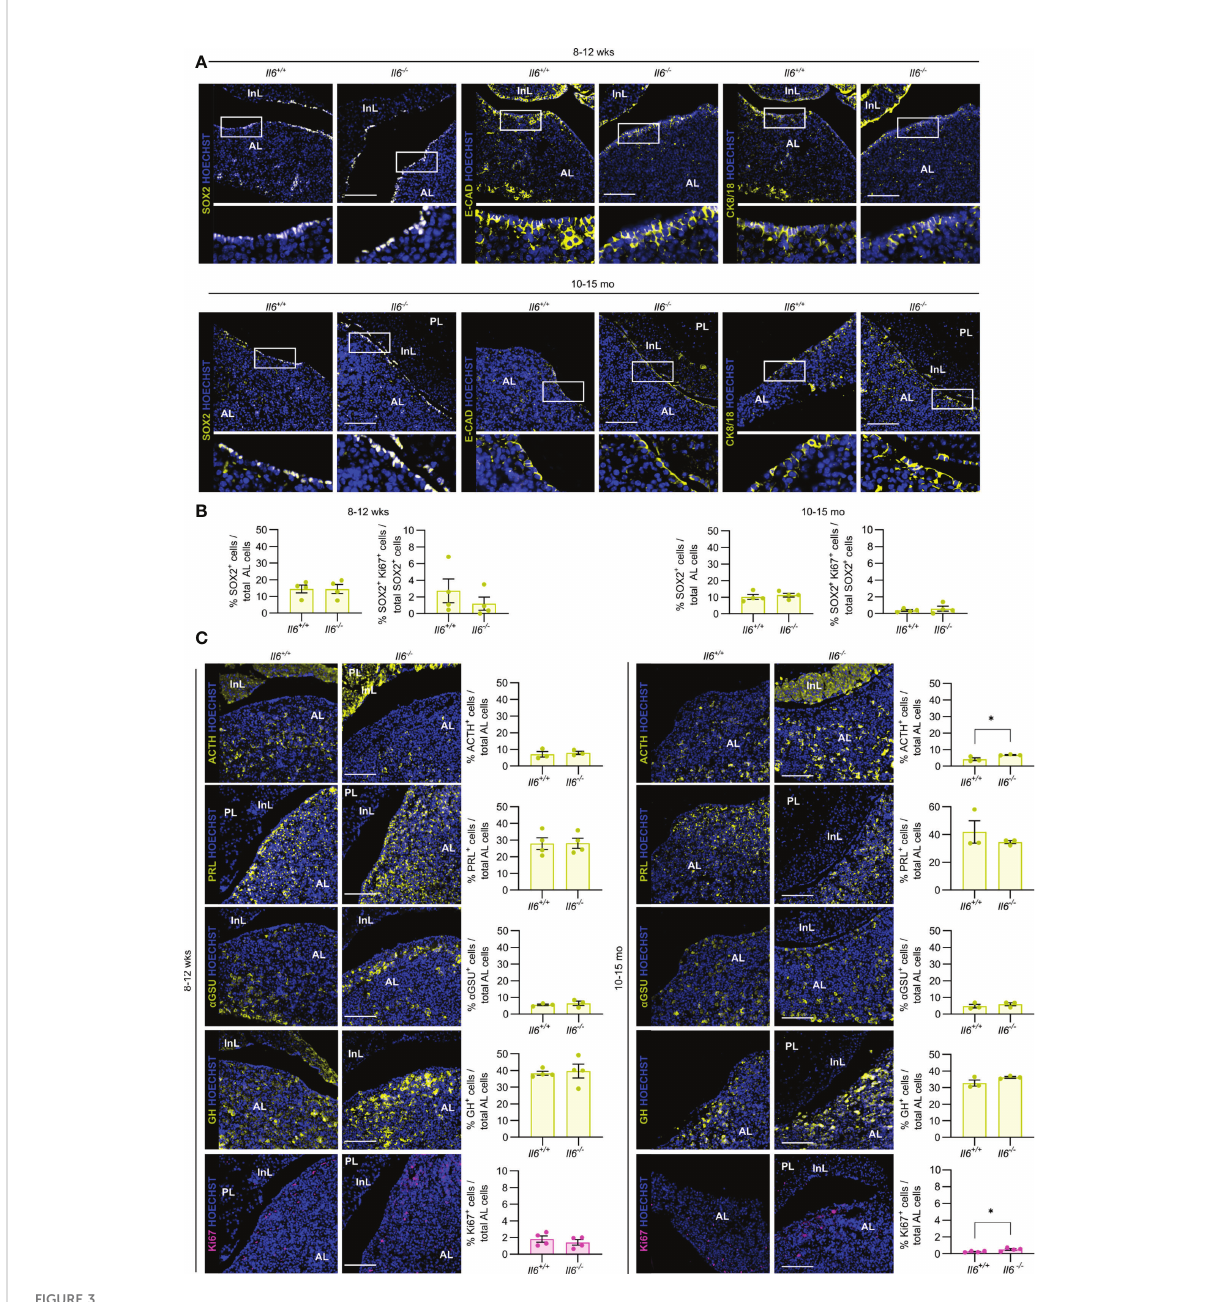
FIGURE 3 Pituitary adult and aging phenotypes are not affected by absence of IL-6. Immuno fl uorescence analysis of adult (8-12 wks) and aging (10-15 mo) Il6 +/+ and Il6 -/- pituitary for SOX2, E-CAD and CK8/18 (all yellow). Hoechst33342 was used as nuclear stain (blue). Boxed areas are magni fi ed in the respective bottom panels. Scale bar, 100 m m (A) . Proportion of SOX2 + cells in total AL cell population or of proliferating SOX2 + Ki67 + cells in the SOX2 + cell compartment. Bars depict mean ± SEM (n = 4, all individually shown; unpaired t-test) (B) . Immuno fl uorescence analysis of adult and aging Il6 +/+ and Il6 -/- pituitary for ACTH, PRL, a GSU, GH (all yellow) and Ki67 (magenta). Hoechst33342 was used as nuclear stain (blue). Scale bar, 100 m m (left). Proportion of hormone + or Ki67 + cells in total AL cell population (right). Bars depict mean ± SEM (n = 3-4, all individually shown; unpaired t-test, *P < 0.05.) (C)